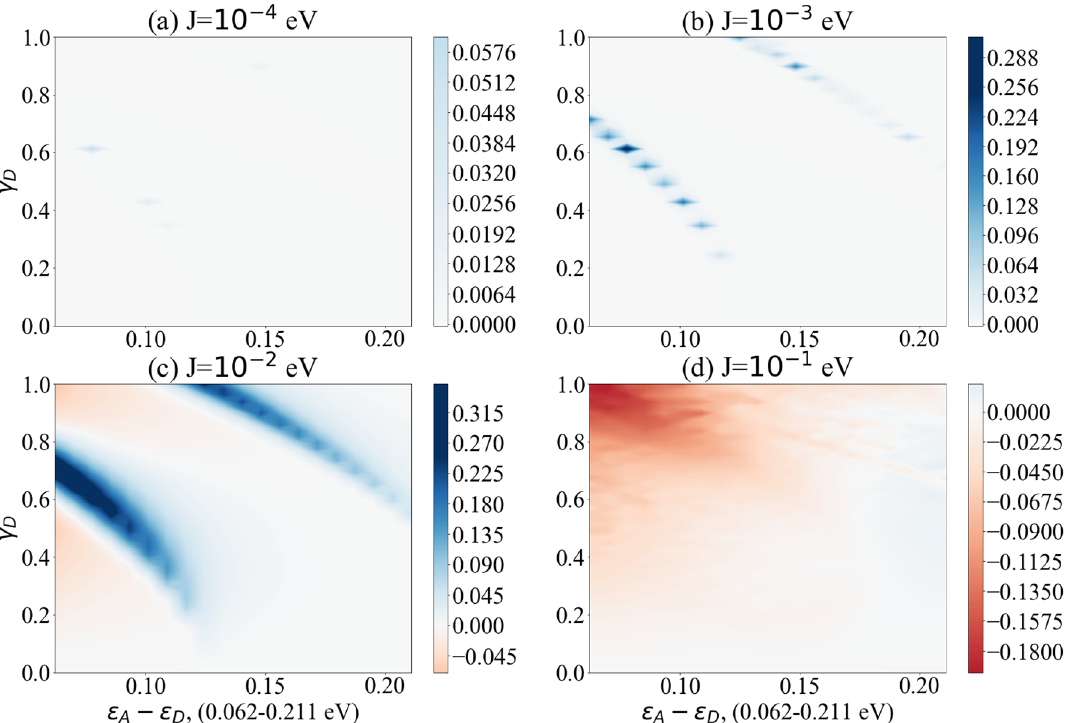
Figure 6. The difference between the maximum probability of transition with and without vibronic mode (cid:31) P Max as a function of the dimer detuning (ε A − ε D ) and the coupling strength between donor and vibronic mode (γ D ) . Results show coupling to vibronic mode frequency ω = 0.1240 eV ( 1000 cm − 1 ). Bluer regions show enhanced transfer with vibronic modes, white regions show no enhancement while redder regions demonstrate decreased transfer. Graphs ( a )–( d ) show the effects of increasing dimer coupling strength by an order of magnitude from J = 0.0001 eV to J = 0.1 eV. The results effectively illustrate the window of (biologically relevant) parameters within which vibration-assisted tunnelling has an effect.